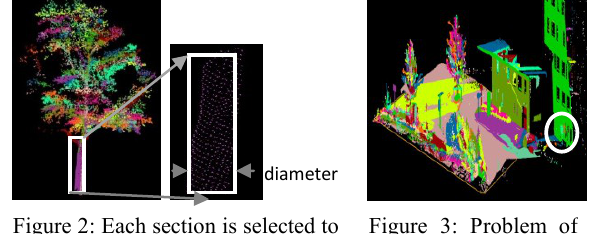
Figure 2: Each section is selected to check whether the segment can be